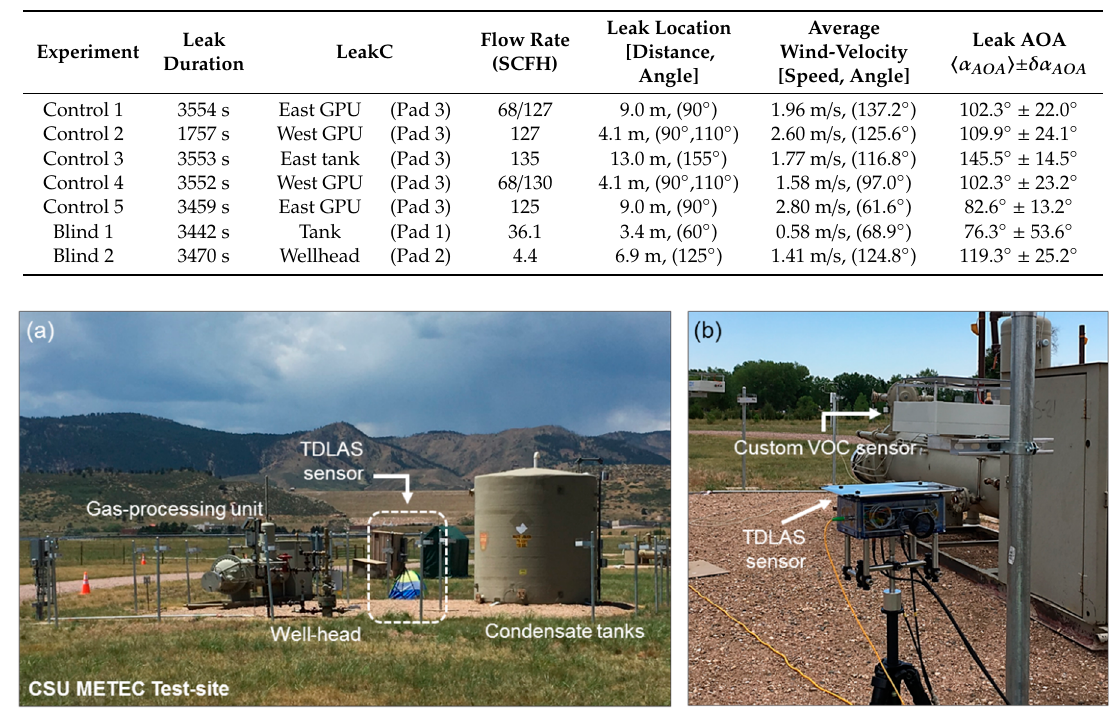
Table 1. Summary of leak experiments at the METEC facility, with calculated leak angle-of-arrival (AOA) (0 ◦ corresponds to North). A total of 6.3 h of leaks from 3 well pads are performed, comprising of 5 control leaks of large magnitude (68 SCFH and above) and 2 blind leaks of smaller magnitude. Control experiments 1 and 4 are split into two flow rates of equal duration, and the two leak location angles in Controls 2 and 4 indicate simultaneous dual-leak points during the experiment.